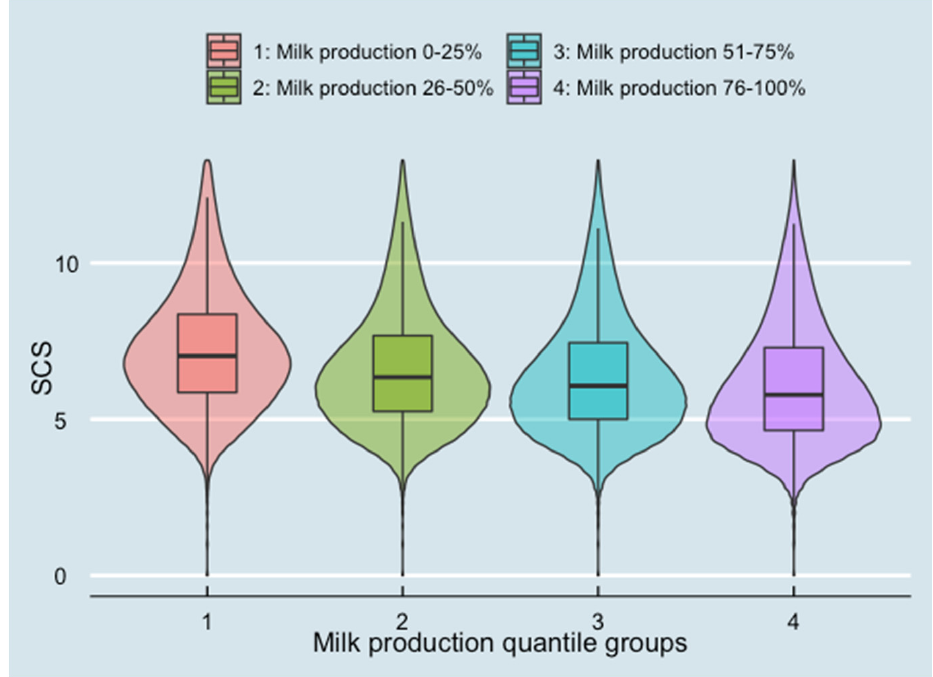
Figure 3. Somatic cell score (SCS) at test-day records level in different milk production quantile groups (10,445,464 test-day records from 826,831 cows on 2970 herds). The violin plot combines the probability density (area under the curve) and box plots.